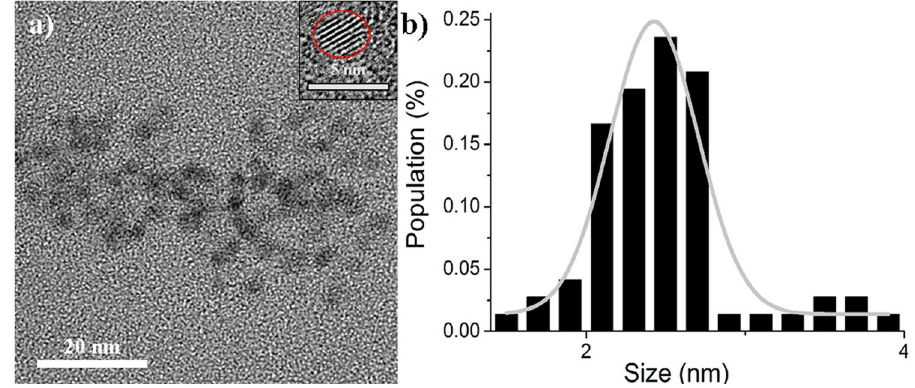
Figure 3. ( a ) TEM image of the N-dots (inset shows the HRTEM image) and ( b ) size distribution histograms of N-dots based on